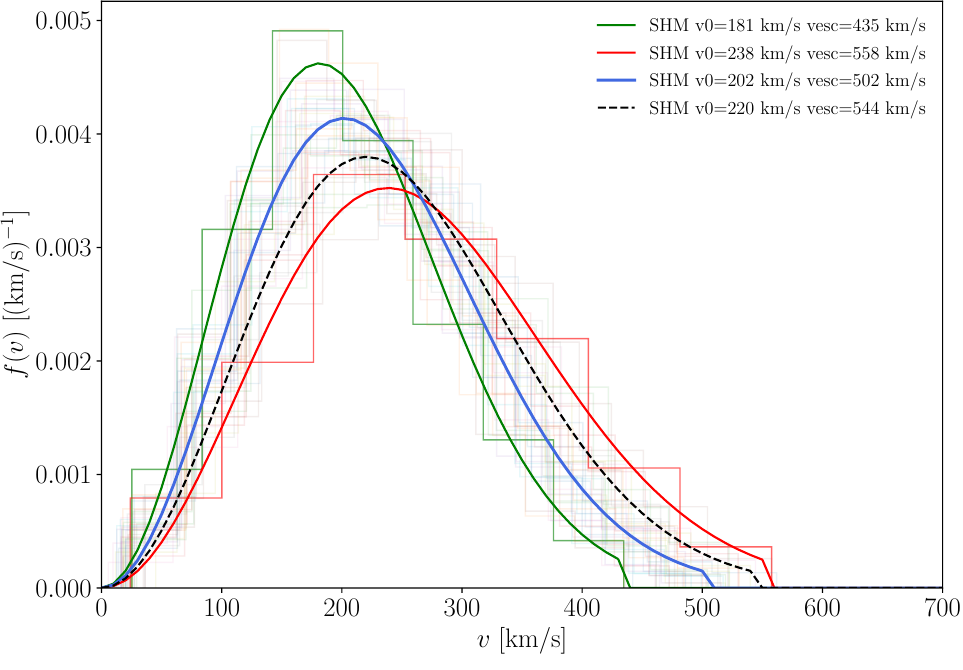
Figure 1 . The histograms of the local dark matter speed distribution in the galactic rest frame for the 36 hydrodynamical TNG100 Milky-Way-like halos selected by our analysis. The red, blue and green solid lines represent the best-(cid:12)t Maxwellian distribution for the minimum (MIN), median (MED) and maximum (MAX) peak speed values, respectively. The histograms corresponding to the MIN and MAX distributions are